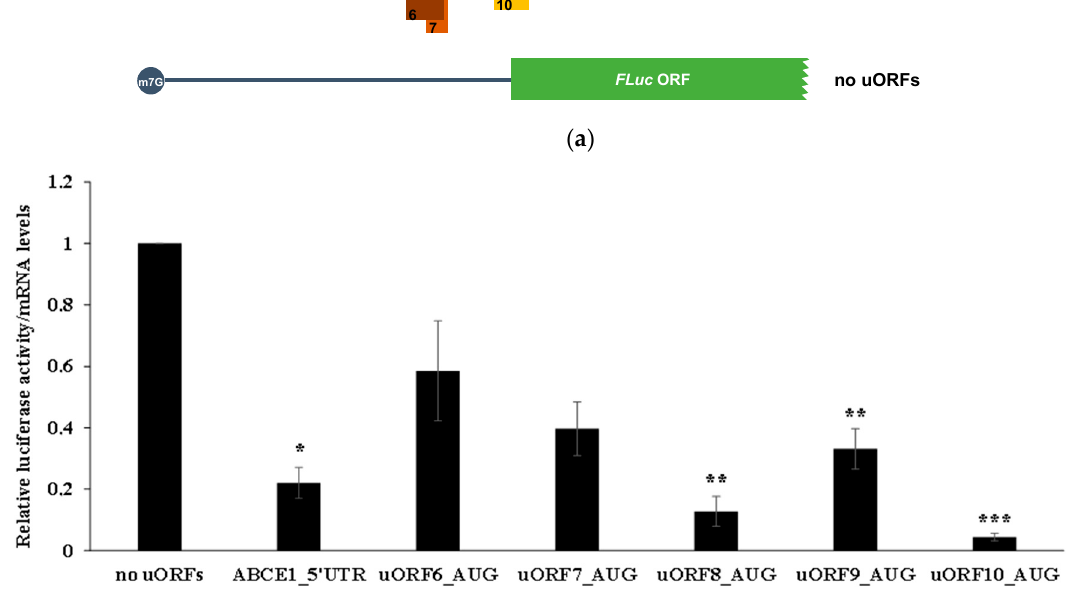
Figure 4. Mutating the ABCE1 non-AUG to AUG uORFs increases their repressive effect over the main coding sequence. ( a ) Schematic representation of the constructs used. The ABCE1_5 ′ UTR construct, containing the intact ABCE1 5 ′ -leader sequence, and the “no uORFs” construct, without any functional AUG and non-AUG uORFs, were already described in Figures 2a and 3a, respectively. By site-directed mutagenesis, and using the construct “no AUG uORFs” (described in Figure 2a) as a template, the start codon of each one of the non-AUG uORFs was mutated (CTG/GTG → ATG), and the